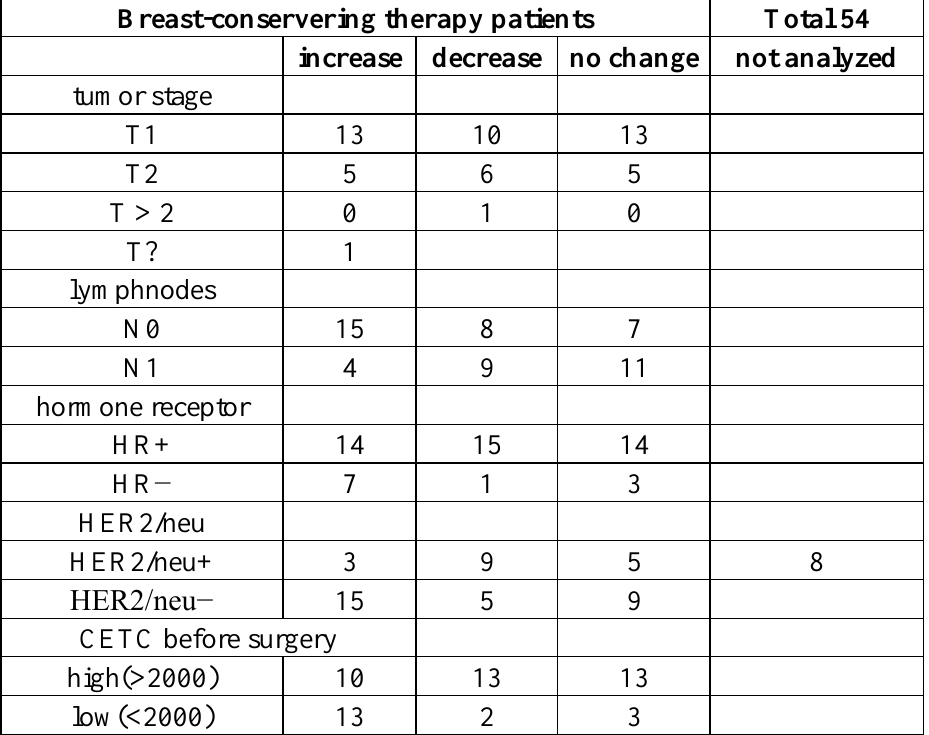
Table 1. Tumor characteristics of patients with increasing, decreasing and no change in CETC after treatment with breast conserving surgery.